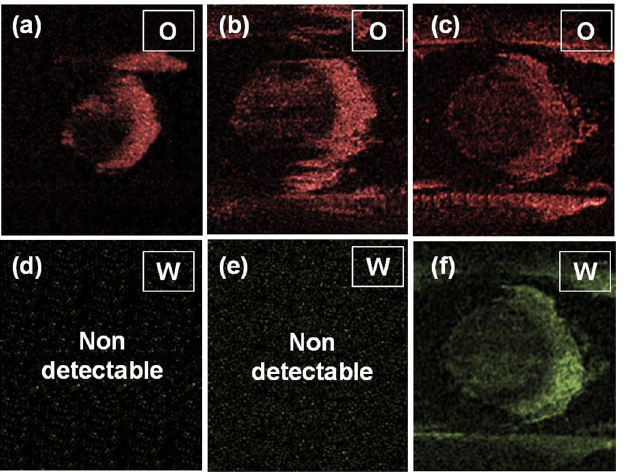
Fig. 12. EDS mapping images for the detection of oxygen (O) at wear tracks of counterpart SUJ2 balls after BOD friction test different texture interspace of 15 m m (a), 30 m m (b), and 50 m m (c) as well as the detection for tungsten (W) (d – f), respectively.